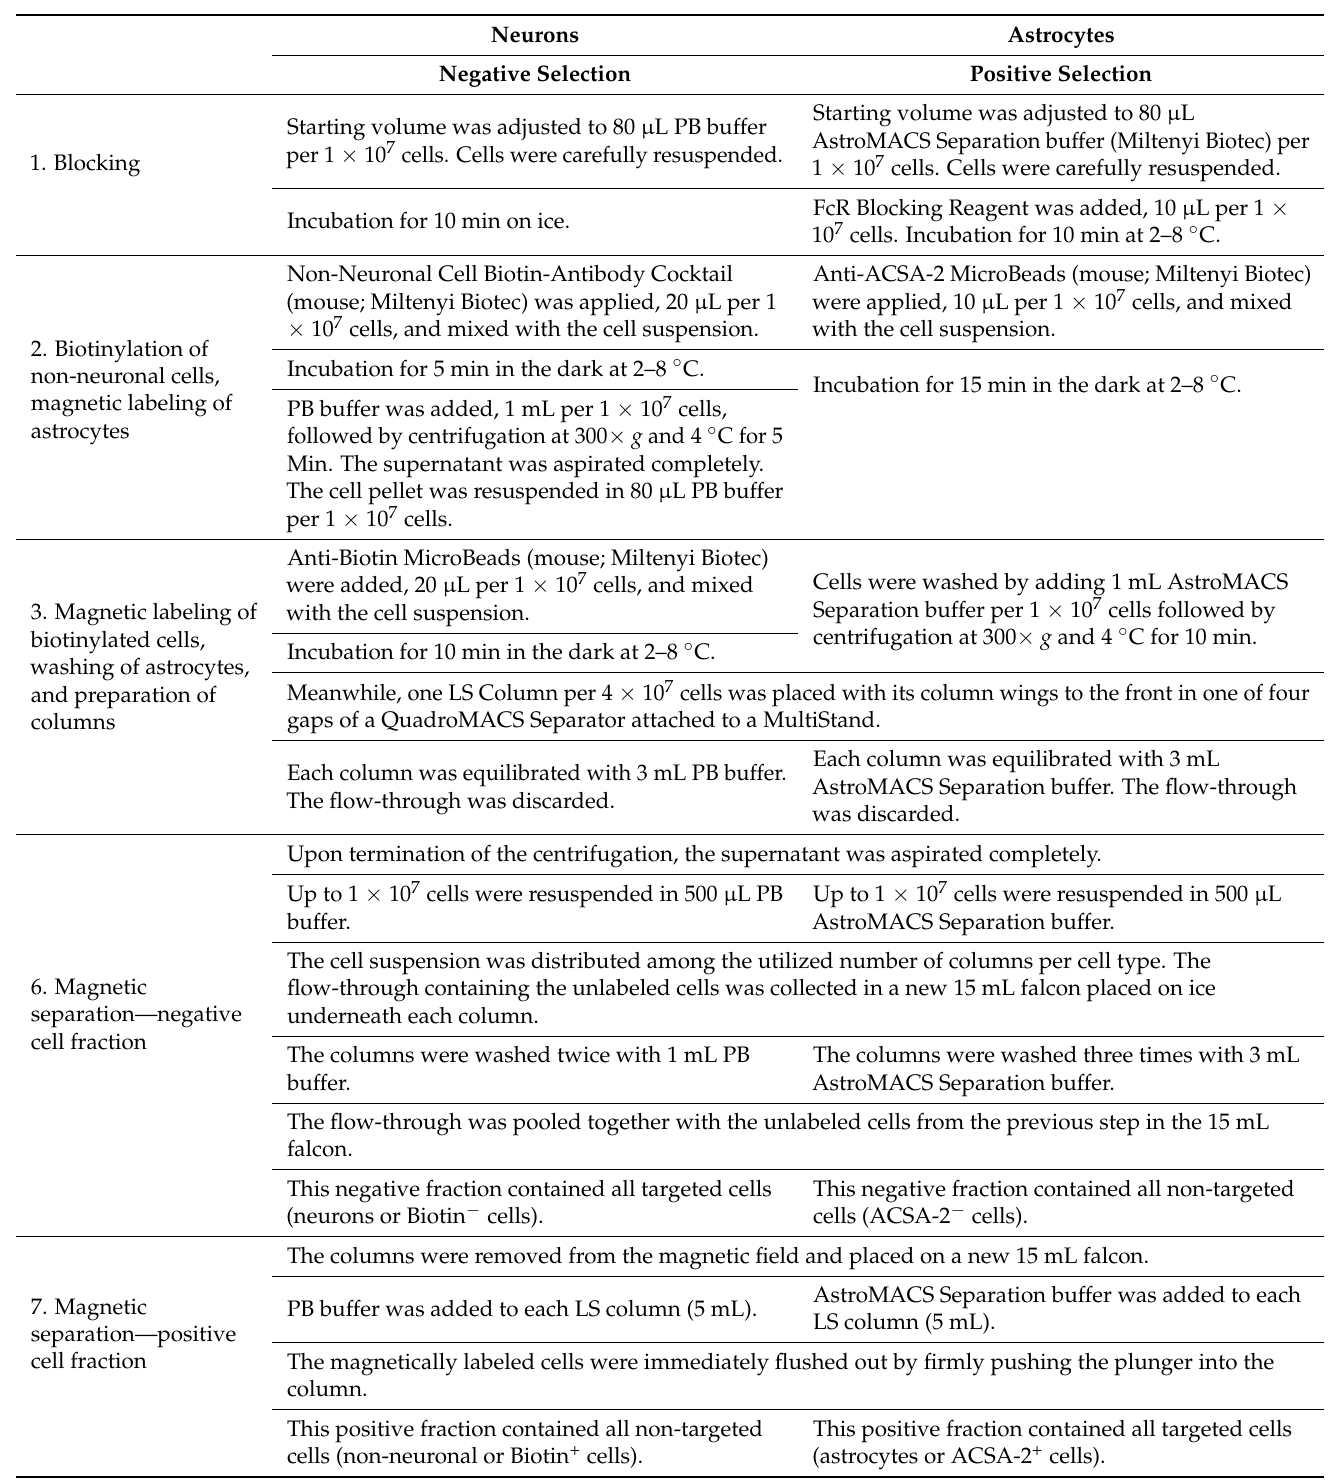
Table 2. Protocol for simultaneous MACS of neurons and astrocytes from naïve and EAE mice. Steps that should be performed at once are listed in the same